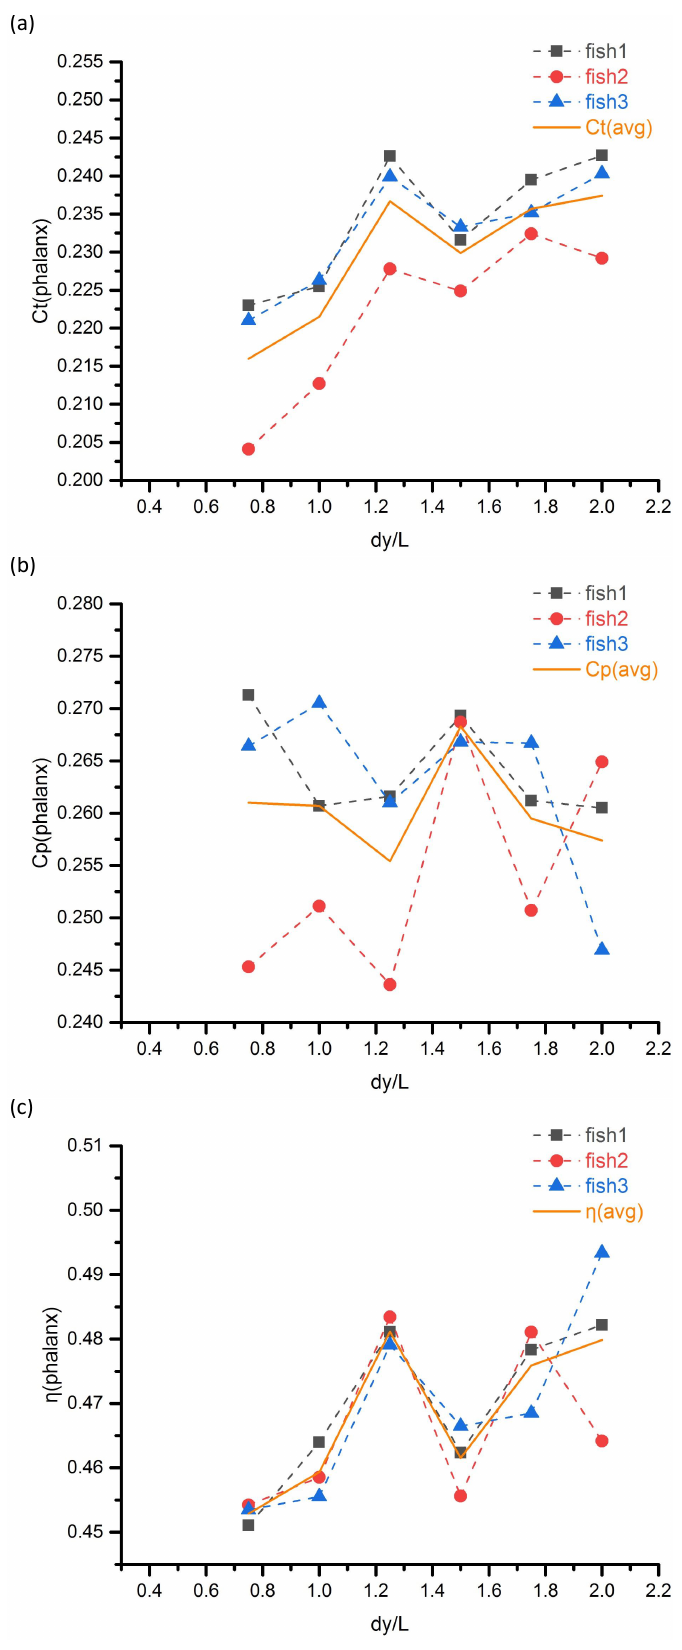
Figure 13. Results of the phalanx swarm: ( a ) non-dimensional thrust coefficients C t , ( b ) non-dimensional lateral power loss coefficients C p , ( c ) the Froude efficiency η